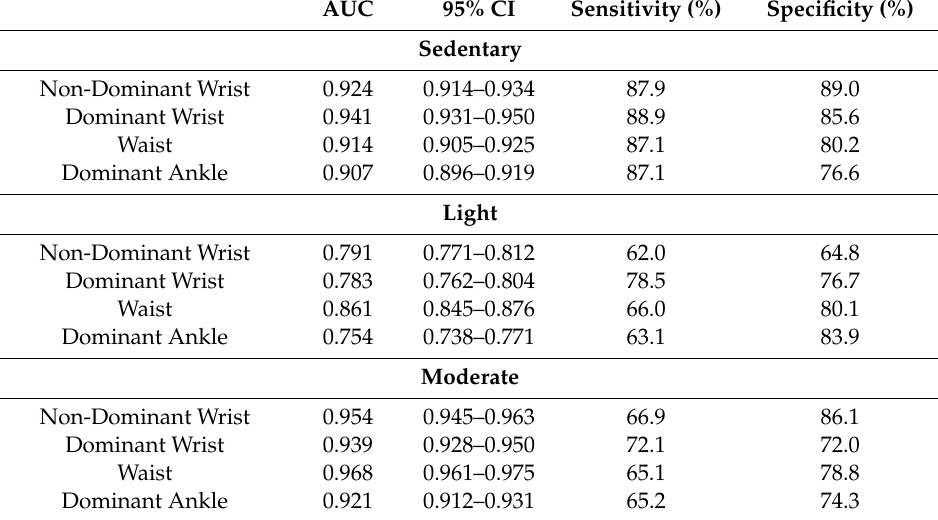
Table 3. AUC, sensitivity and specificity of the cut-points derived in the current study, when applied to the data from the Duncan et al. [14] study to correctly distinguish the breath by breath derived MET values.